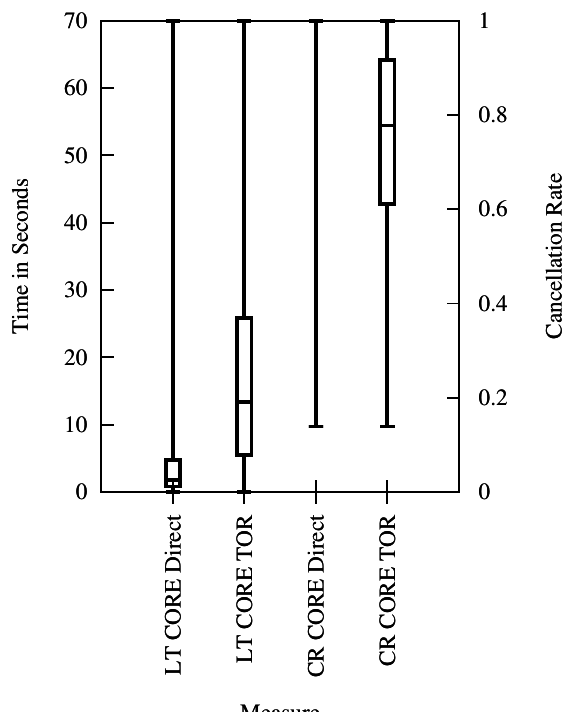
Figure 11. Core Latency and Cancelation Rate (Lab Experiment without Feedback).